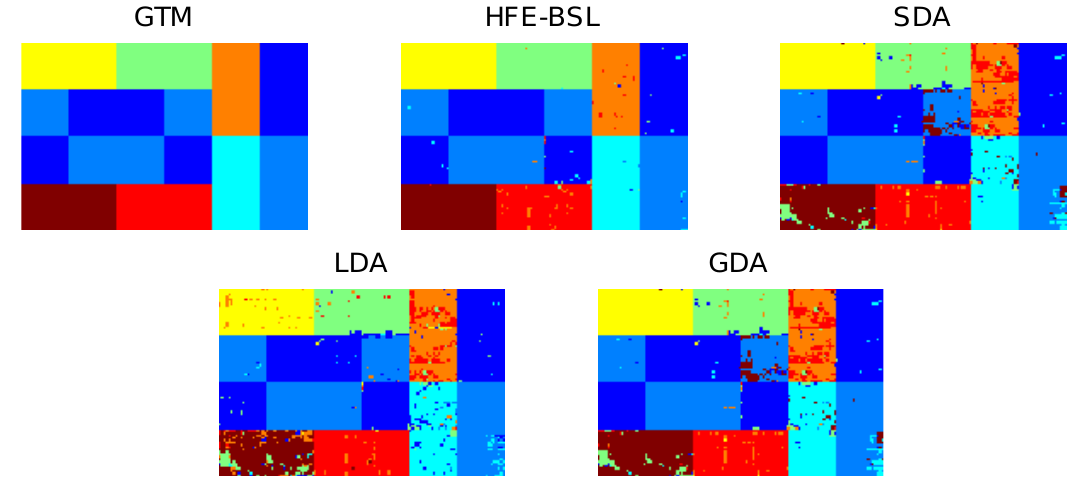
Figure 3. GTM and classification maps for synthetic dataset (16 training samples and 7 extracted features are used).